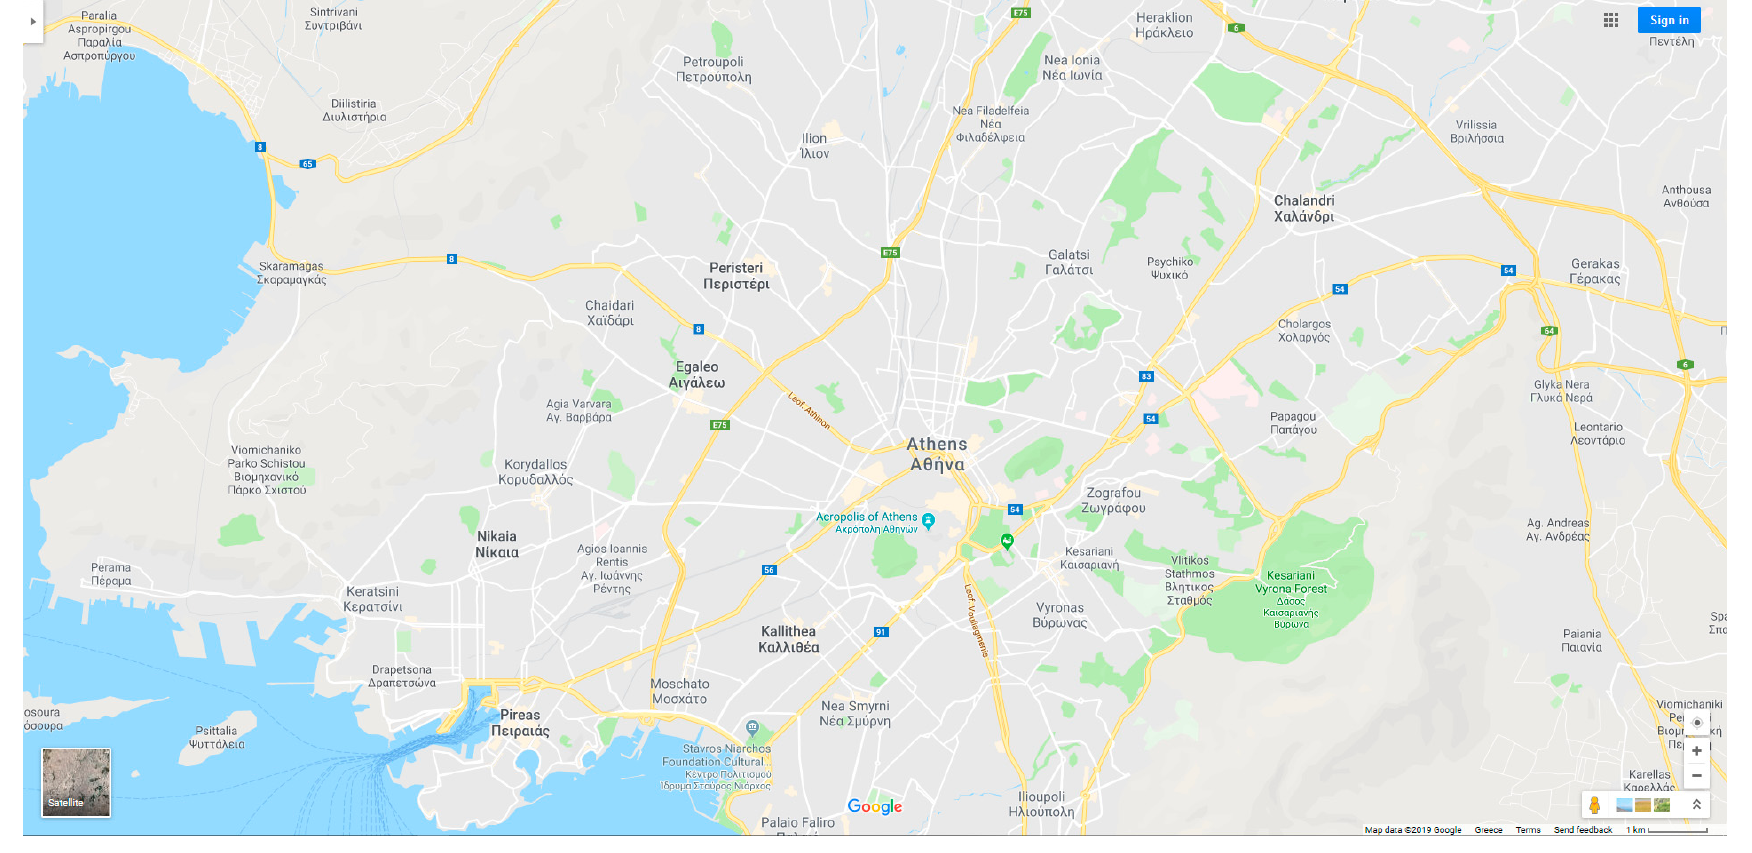
Figure A1. Google maps (https://www.google.com/maps/@37.989609,23.7156318,13z).